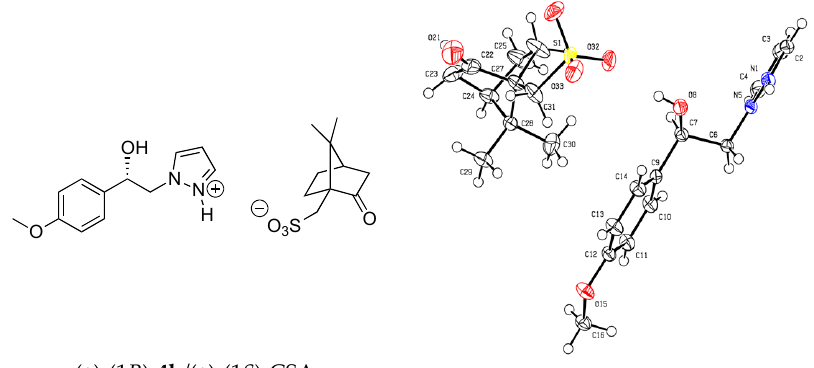
racemic 4b , and after diastereomeric enrichment, the other diastereomer [(+)-(1 R )- 4b /(+)-(1 S )-CSA, (>99% de)] was obtained in 51% yield with [ α D ] = +6.0 ( c 1.0, MeOH). Crystal structures of the salt diastereomers were determined by X-ray crystal structure analysis, as example the diastereomer (+)-(1 R )- 4b /(+)-(1 S )-CSA is shown in Figure 2. Table 3. Products issued from resolution of (±)-(1 R , 1 S ) 1-(4-methoxyphenyl)-2-(1 H -pyrazol-1-yl) ethan-1-ol 4b with ( − )-(1 R )-CSA and (+)-(1 S )-CSA using the method of “half-quantities”. Figure 2. Ortep diagram of (+)-(1 R ) 1-(4-methoxyphenyl)-2-(1 H -pyrazol-1-yl)ethan-1-ol 4b /(+)-(1 S )-10-camphorsulfonic acid obtained by X-ray diffraction. During the resolution of the (±) racemic mixture 4b by the “half-quantities” protocol with ( − )-(1 R )-CSA or (+)-(1 S )-CSA and neutralization of the two diastereomers, all these compounds were submitted to chiral HPLC analysis with a Chiracel OJ-H column (250 × 4.6 i.d. mm) and a UV NOH detector at 220 nm using hexane/ i- PrOH as mobile phase with appropriate composition and flow N rate.